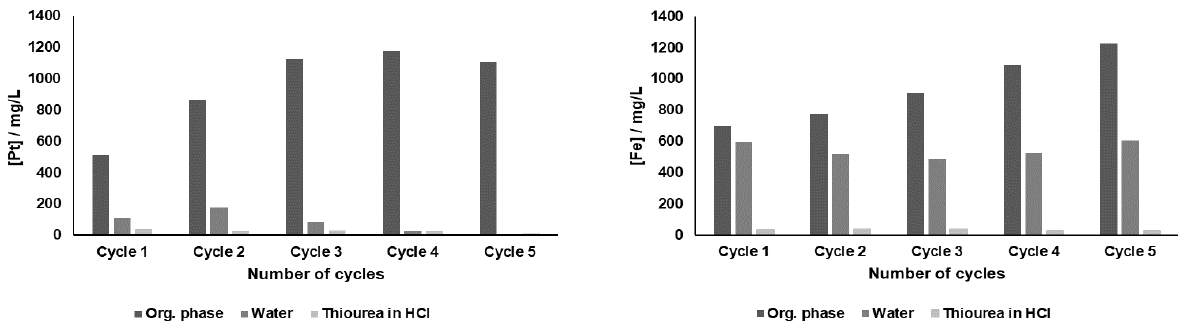
Figure 5. SX profiles shown by 0.25 M DMDCHTDGA in toluene towards Pt and Fe in the SACC leaching solution, through the metal existing concentrations in organic phase after extraction, in water (scrubbing) and in thiourea in HCl (stripping), during five cycles of reutilization.